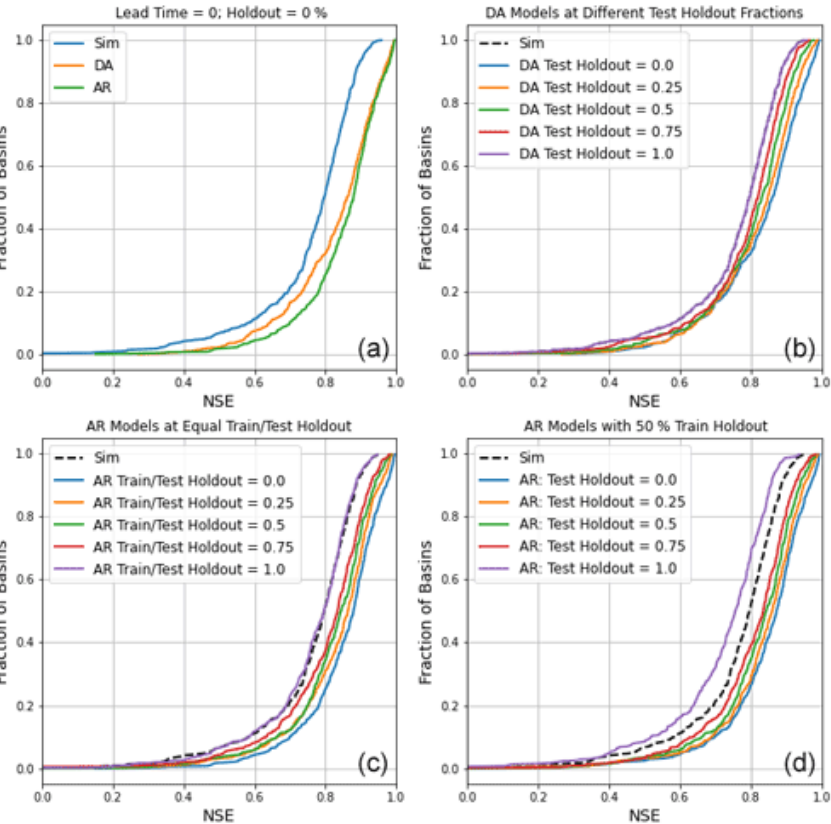
Figure 3. Cumulative density function (CDF) plots of per-basin NSE scores. (a) Comparison between the main model types with no holdout. (b) Comparison of DA models with different holdout fractions during inference (testing). (c) Comparison of AR models with equal train and inference (test) holdout fractions. (d) Comparison of AR models with 50% train holdout and varying inference holdout. All results from lead times of